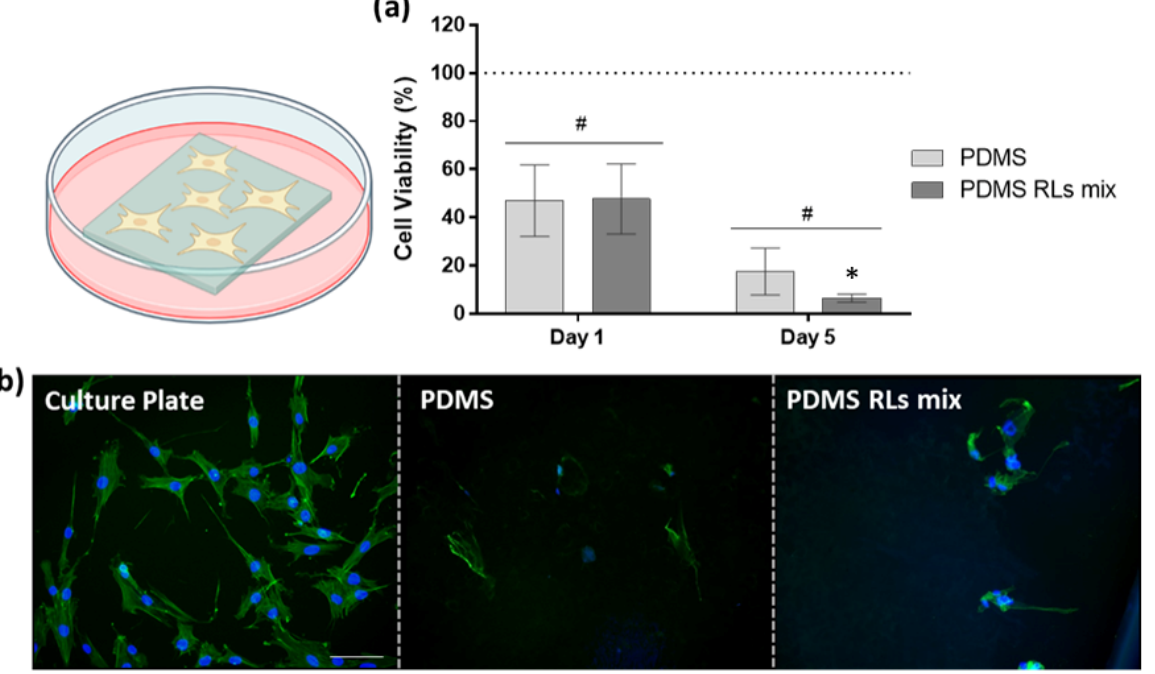
Figure 5. Direct assay—HDFs cultures were seeded directly over PDMS’ materials: ( a ) cell viability/metabolic activity assessed by resazurin assay; cells seeded on the culture plate were used as control, set as 100%; # significantly different from control; * significantly different between experimental conditions, p ≤ 0.05; ( b ) representative fluorescence images of the cell morphology and culture organization at 24 h; actin cytoskeleton was stained in green, while the nuclei were counterstained in blue; scale bar: 100 µm.